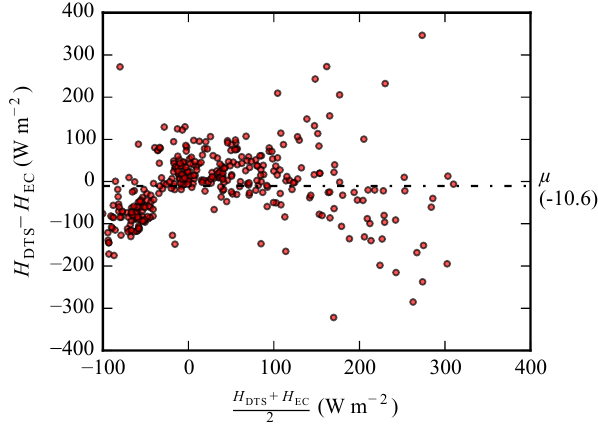
Figure 6. Correlation between the DTS-measured ( β DTS ) and EC- measured ( β EC ) Bowen ratios. Daytime data are between 07:00 and 18:00. Data from 10, 12–14, 19–22, and 28–30 August. R 2 = 0 . 59. RMSE = 0.81. n = 319 data points.